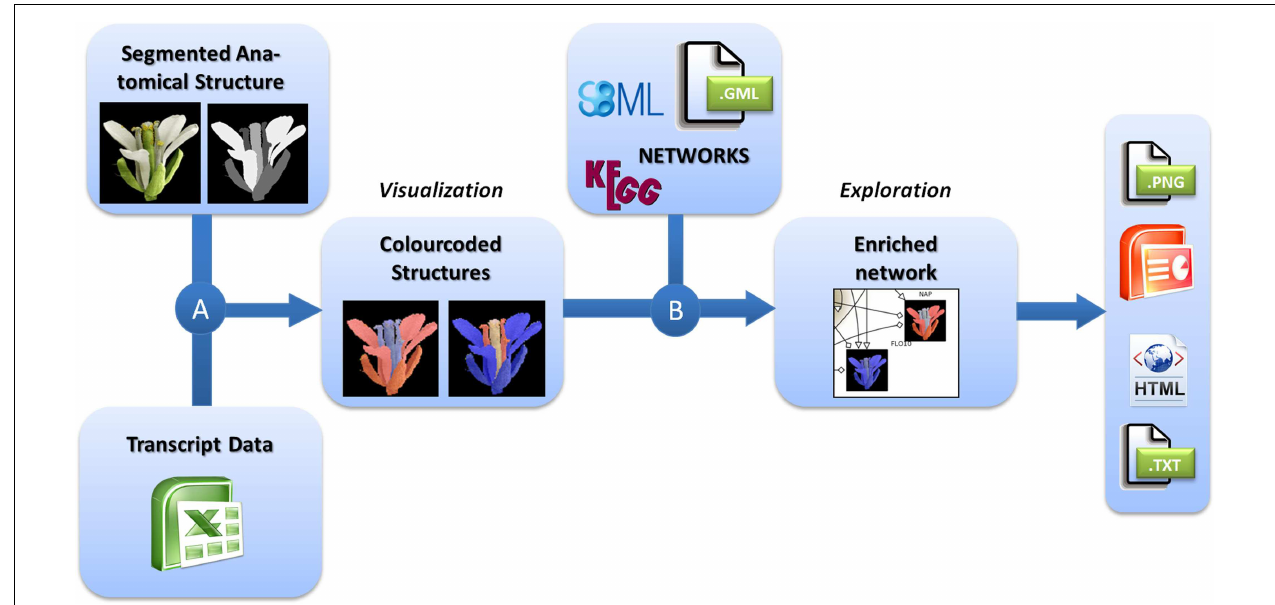
FIGURE 1 |Workflow for the visualization of transcriptomics data on images in the context of biological networks. (A) Transcriptomics and 2D images of anatomical structures are integrated by color-coding of image segments according to the respective transcript data. (B) These color-coded images are integrated into nodes of biological networks. Such integrated views can be explored interactively and exported in various formats for individual purposes.